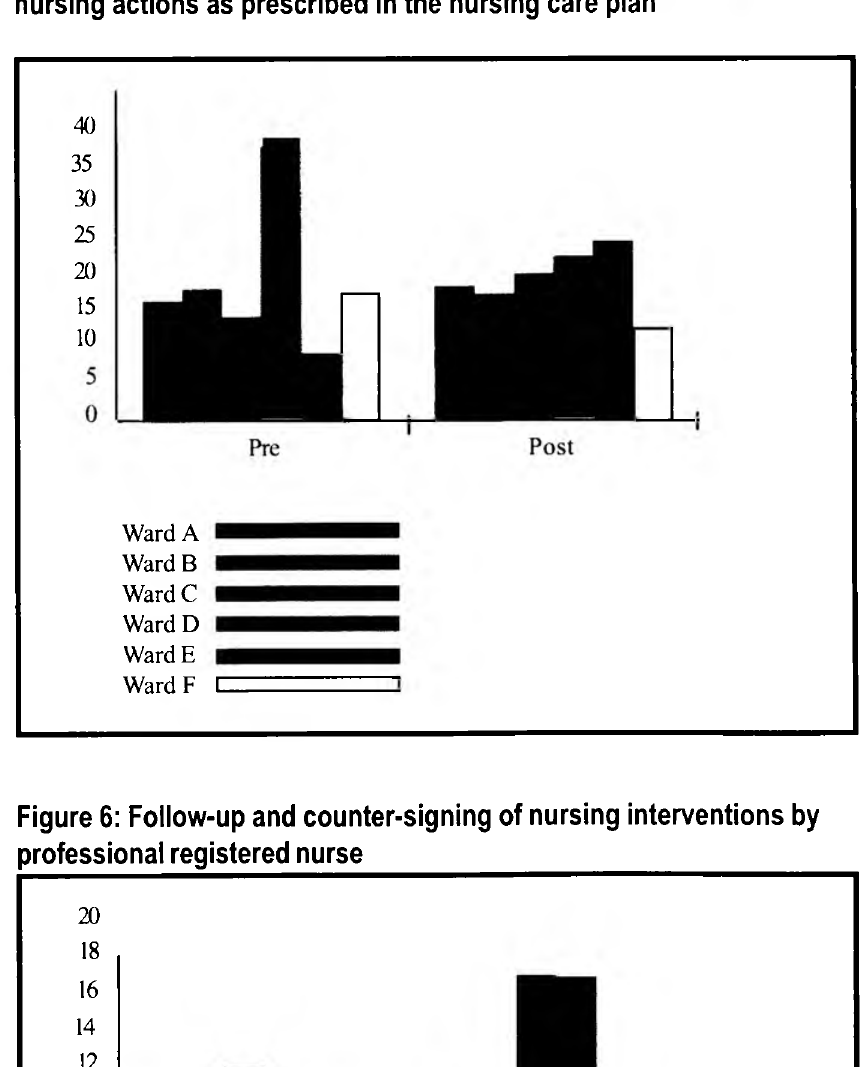
Figure 5: Level of associations of recorded nursing actions with the nursing actions as prescribed in the nursing care plan